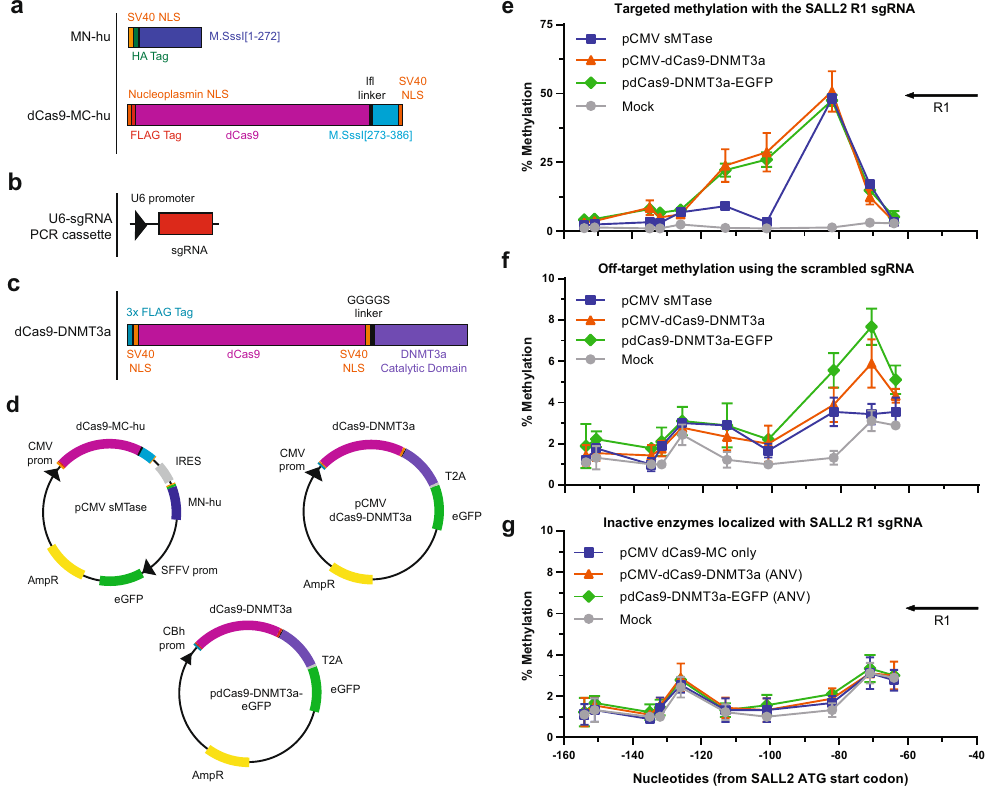
Figure 4. Comparison of the dCas9-sMTase system versus dCas9-DNMT3a fusion. ( a ) Codon optimized versions of the dCas9-MC and MN proteins for use in human cells with nuclear localization signals (NLS) and tags. ( b ) U6-sgRNA PCR cassettes were used for sgRNA expression. (c) dCas9-DNMT3a constructs from Vojta et al . 27 . (d) Schematics showing the pCMV sMTase, pCMV dCas9-DNMT3a-EGFP, and pdCas9- DNMT3a-EGFP expression plasmids. Methylation for biological replicates (n = 3) were measured at the SALL2 P2 promoter for 10 CpG sites ranging from − 64 nt to − 154 nt upstream of the translation start site in the HEK293T cell. Methylation levels are shown with standard deviations for plasmids expressing active methyltransferases plasmids using (e) R1 sgRNA or (f) a scrambled sgRNA. (g) Inactive versions of the dCas9- sMTase (dCas9-MC-hu only) or the pCMV dCas9-DNMT3a-EGFP and pdCas9-DNMT3a-EGFP systems using catalytically dead DNMT3a versions (ANV) localized using the SALL2 R1 sgRNA were also